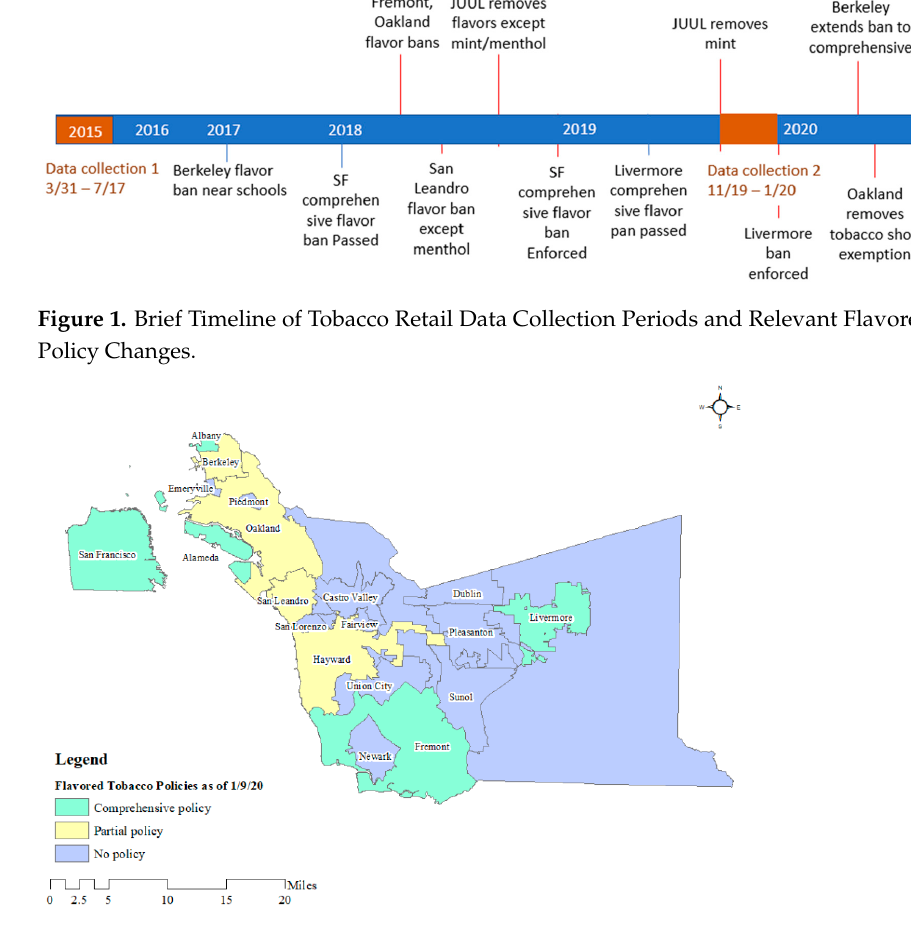
Figure 2. Alameda and San Francisco County Cities Color-Coded According to Comprehensiveness of Flavored Tobacco Sales as of January